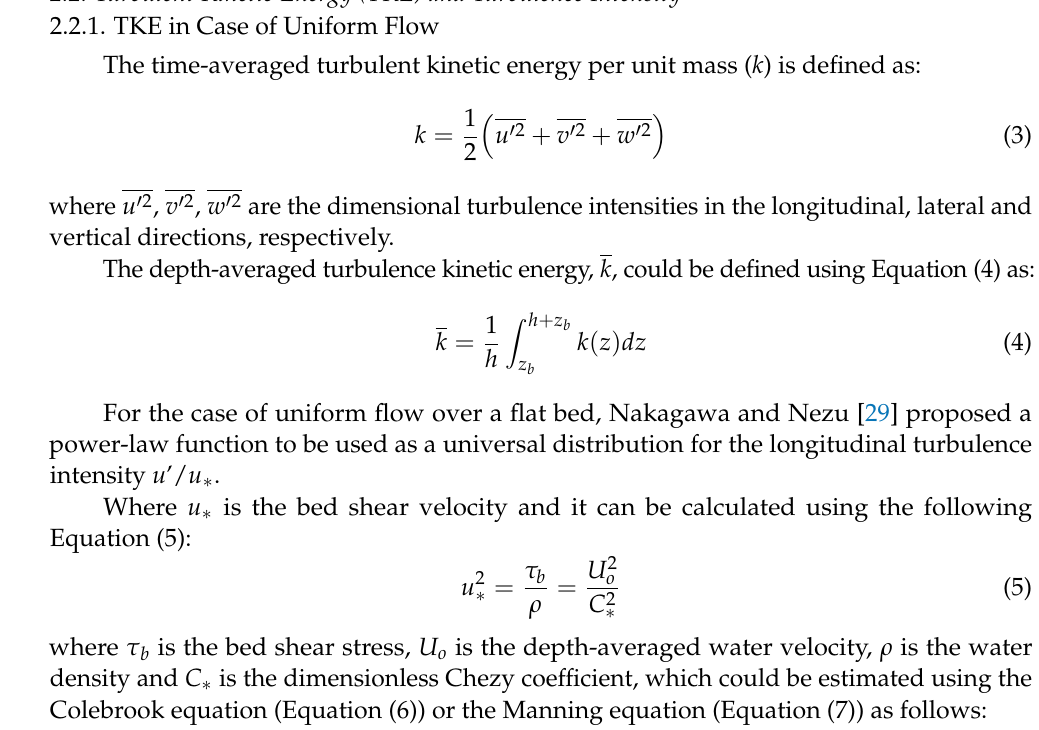
Figure 2. Variation in the Integral Moment Velocity Scale u 1 for Accelerating and Decelerating Flow. ( a ) Decelerating Flow, ( b ) Accelerating Flow.